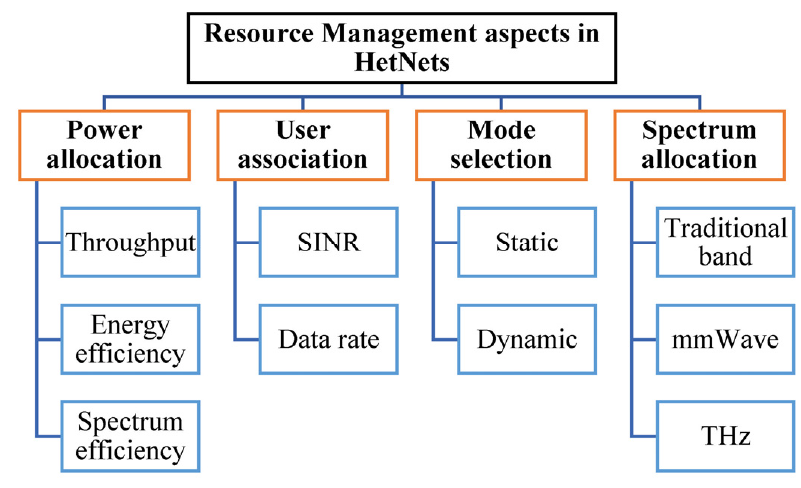
Figure 4. Resecures management aspects.